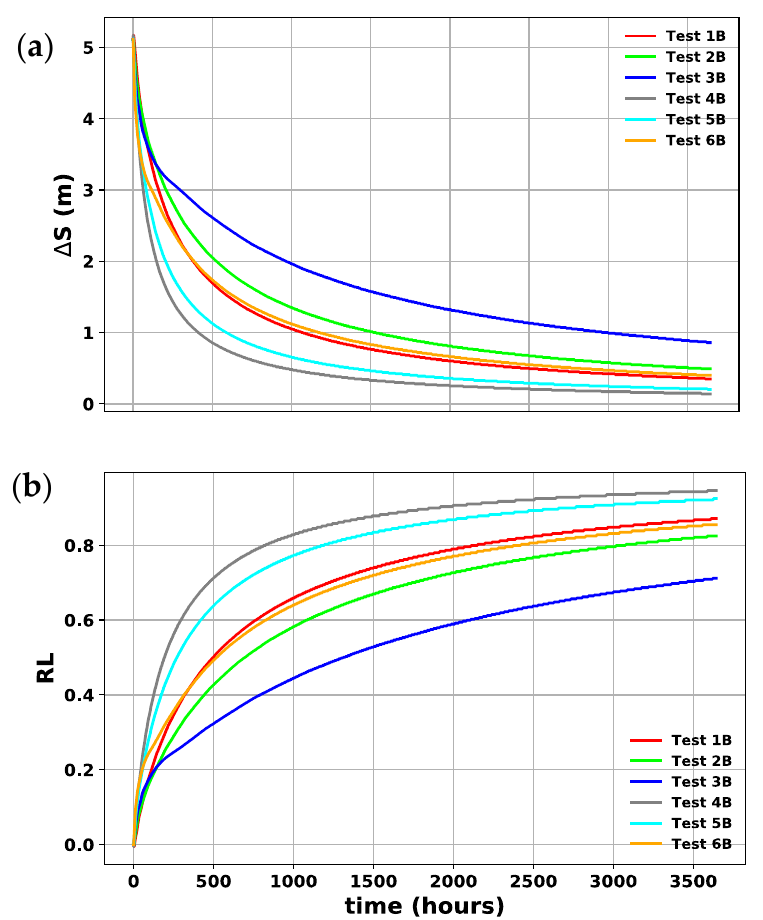
Figure 15. Beach resilience after structure removal: ( a ) shoreline change with respect to time after the structure removal and ( b ) resilience index temporal